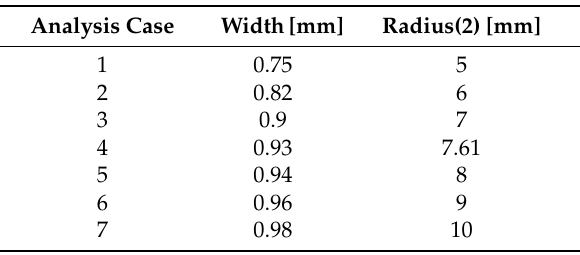
Table 3. Rotor notch radius parameter.